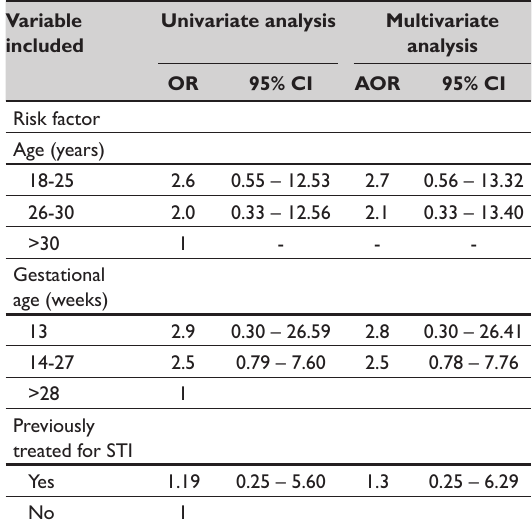
Table 1: Factors associated with C.